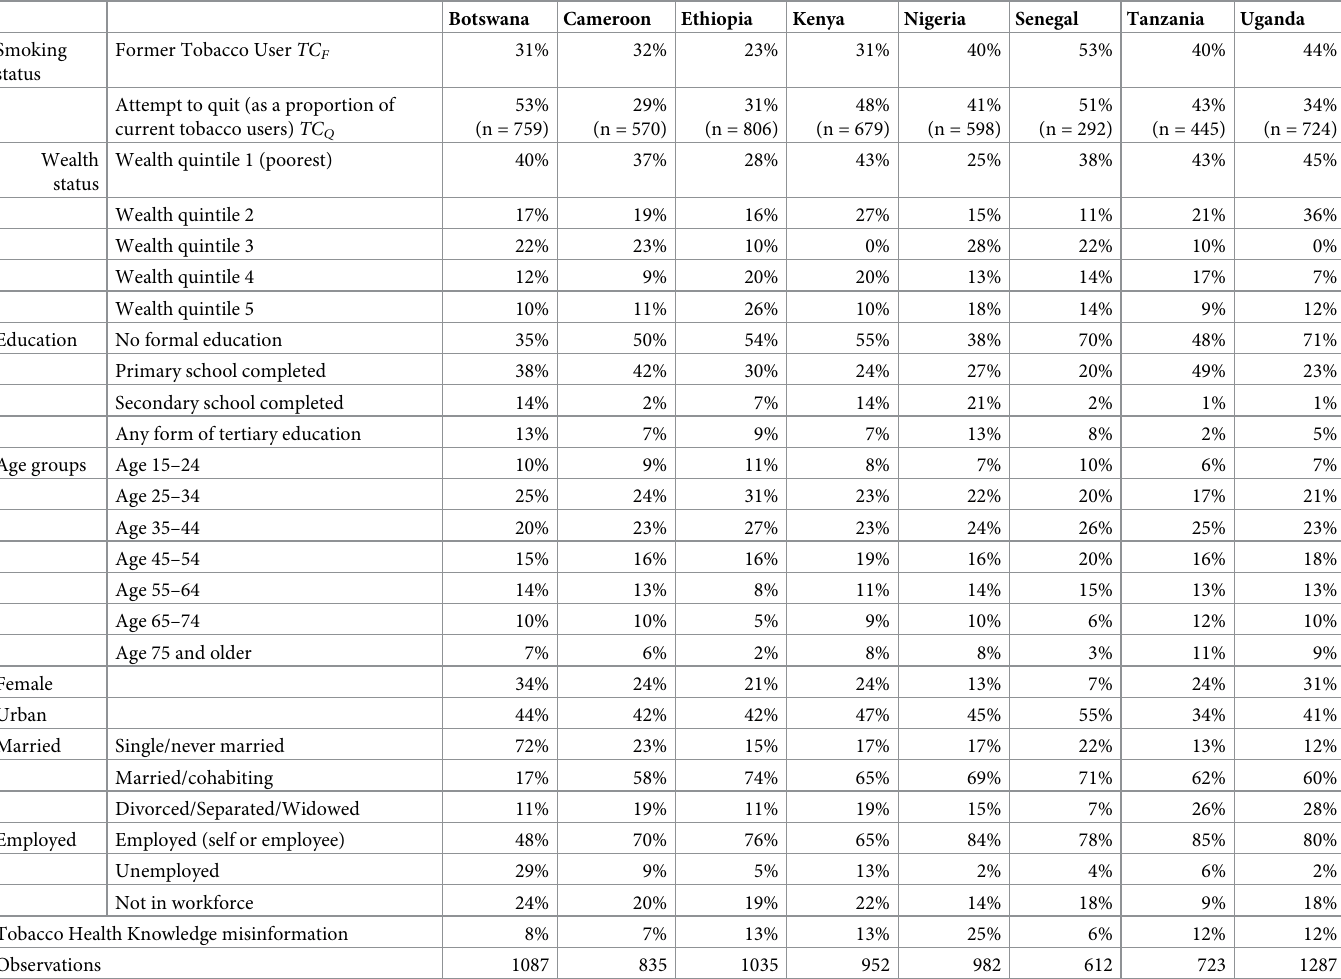
Table 1. Descriptive statistics of dependent and independent variables for Botswana, Cameroon, Ethiopia, Kenya, Nigeria, Senegal, Tanzania and